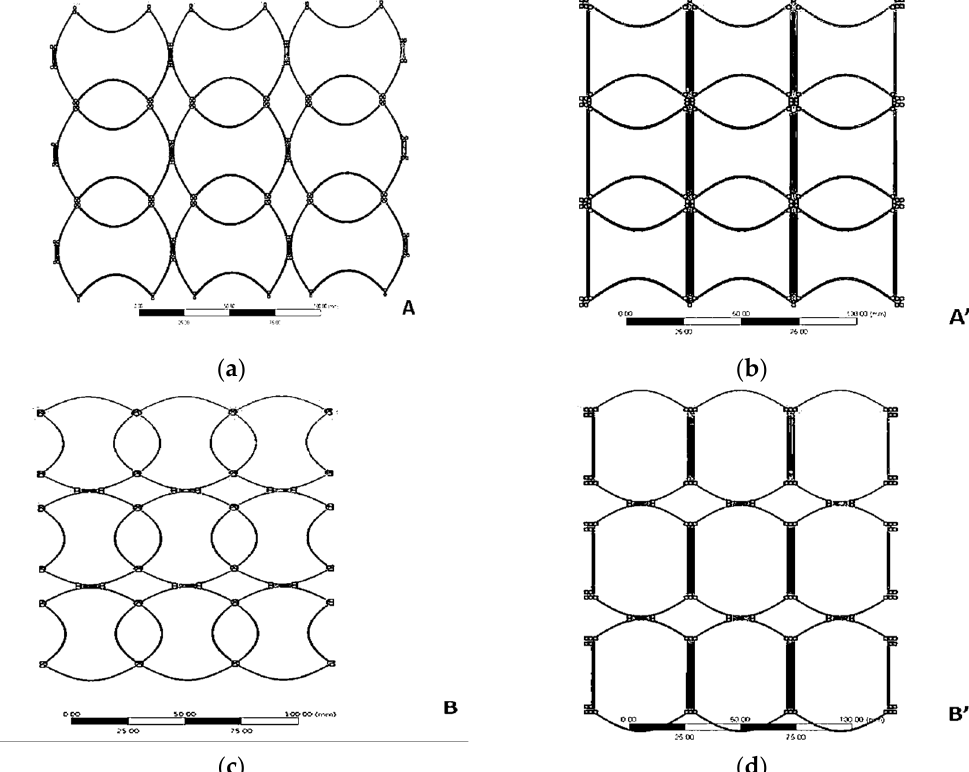
Figure 10. 3 × 3 SIN waveforms: ( a ) A, ( b ) A’, ( c ) B, ( d ) B’, types. The finite element software was used for the stretching tests to observe the changes tions. The arrays (3 × 3 and 4 × 4) were stretched to 5 mm, 10 mm, 15 mm, and 20 mm by